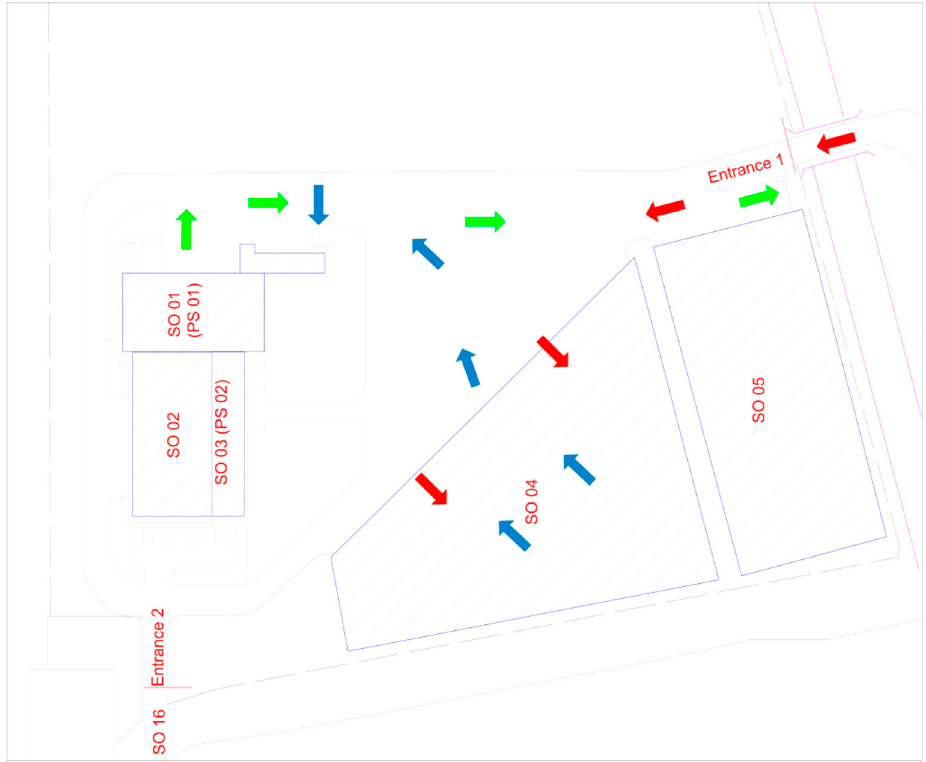
Figure 3. The direction of the fuel handling (source: by authors).